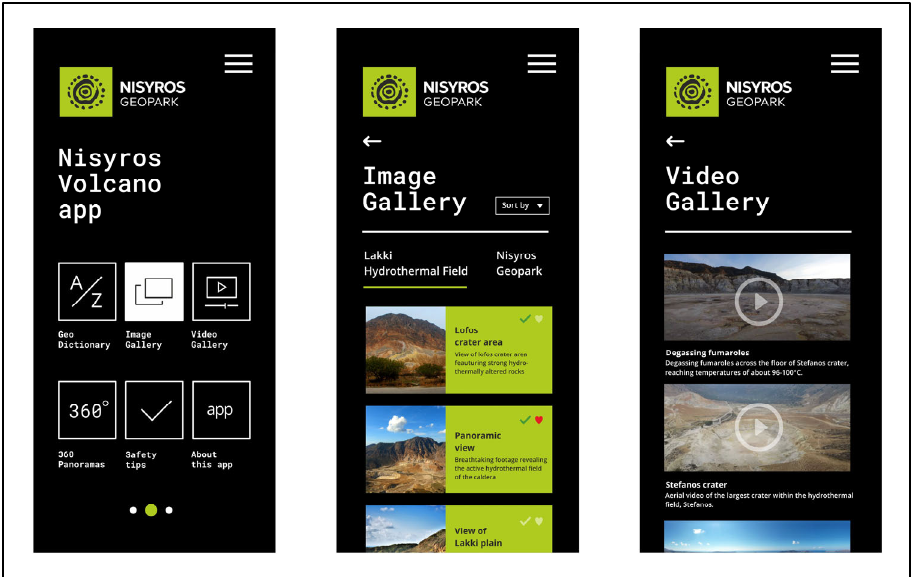
Figure 13. Screenshot examples of the contents of Nisyros Volcano App. Here, the second informa- tional level’s total subunits, the ‘Image Gallery’ and ‘Video Gallery’ subunits are presented.